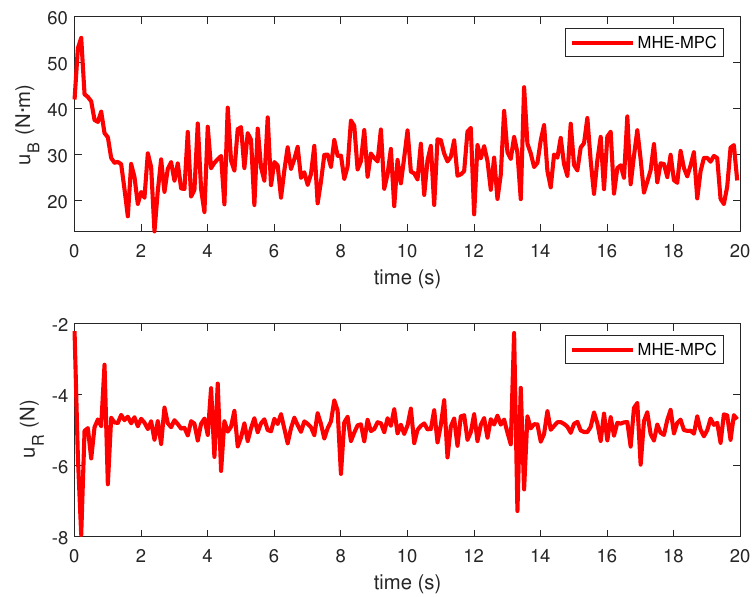
Figure 15. Case 3: control inputs u B and u R